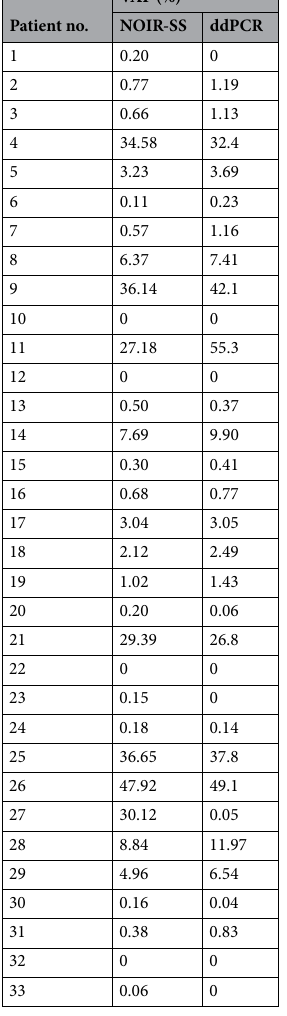
Table 2. Variant allele fraction of EGFR L858R mutations in NOIR-SS and ddPCR. Abbreviations: EGFR epidermal growth factor receptor, NOIR-SS nonoverlapping integrated read sequencing system, ddPCR droplet digital PCR, VAF variant allele